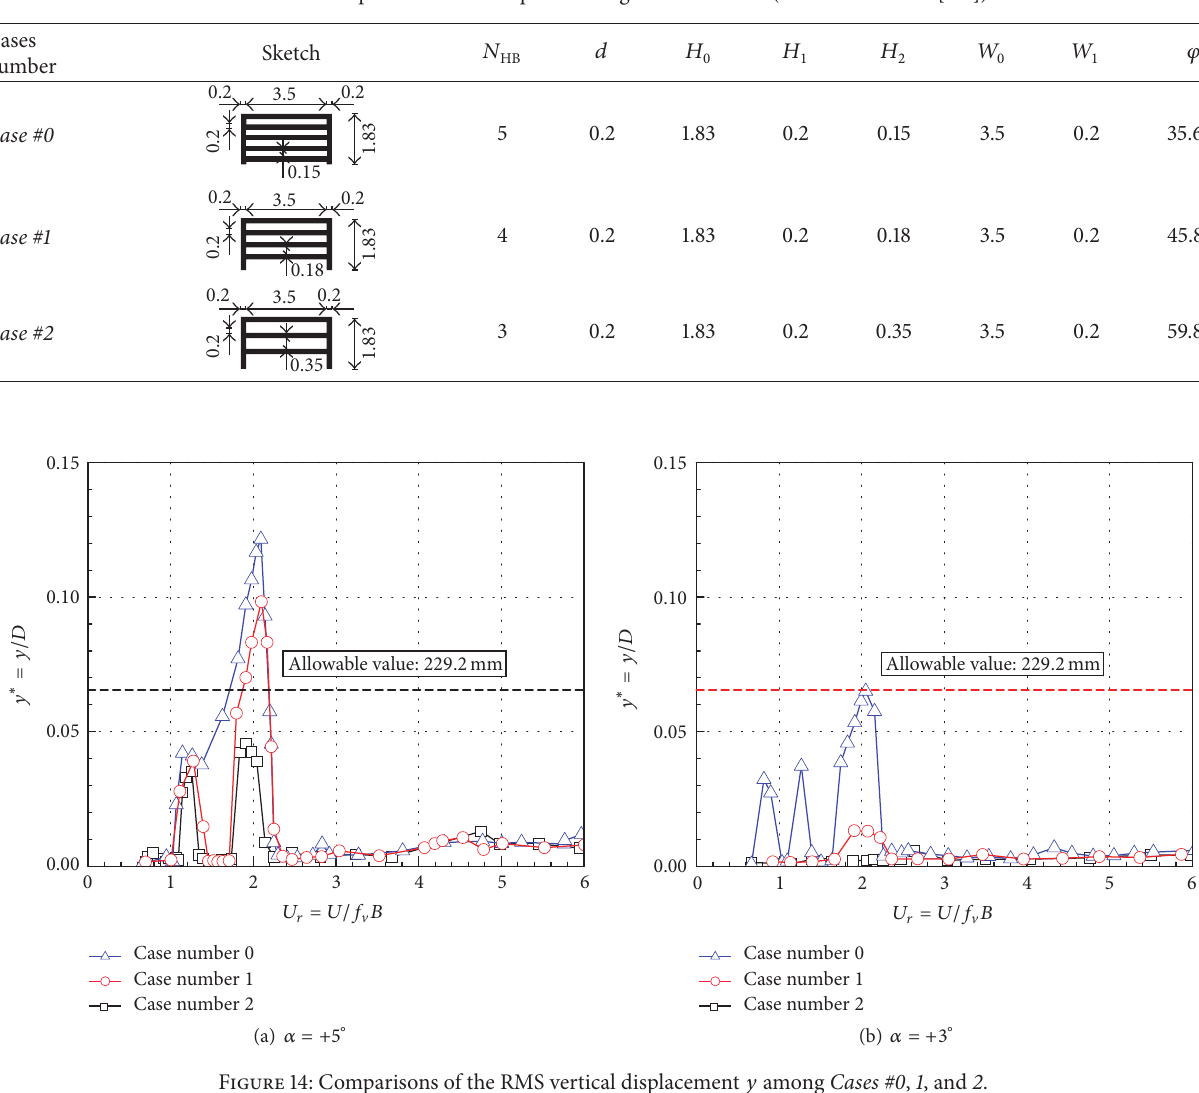
Figure 14: Comparisons of the RMS vertical displacement 𝑦 among Cases #0 , 1 , and 2